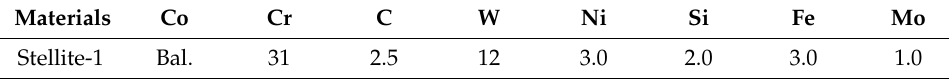
Table 1. Chemical compositions of Stellite-1 powder used (wt.%).